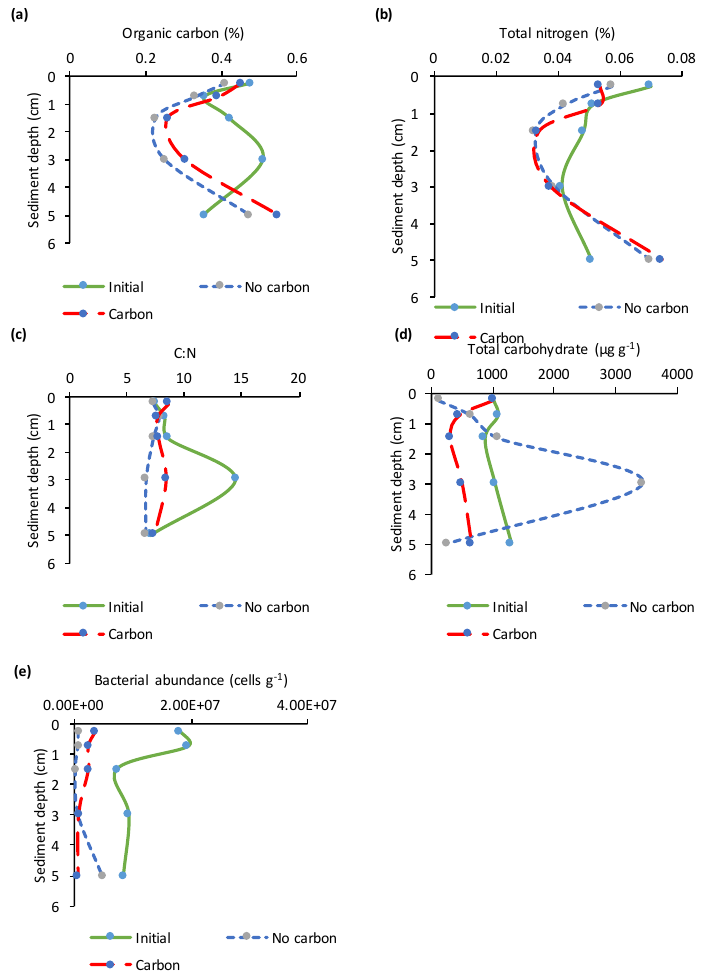
Figure 3. Vertical depth profiles of sediment characteristics: (a) organic carbon, (b) total nitrogen, (c) carbon-to-nitrogen ratio (C:N), (d) total carbohydrate and (e) bacterial abundance. Cores were sectioned on day 0 prior to the addition of aquaculture waste (initial; In) and after waste addition, both with and without carbon supplementation (carbon and no carbon respectively) on day